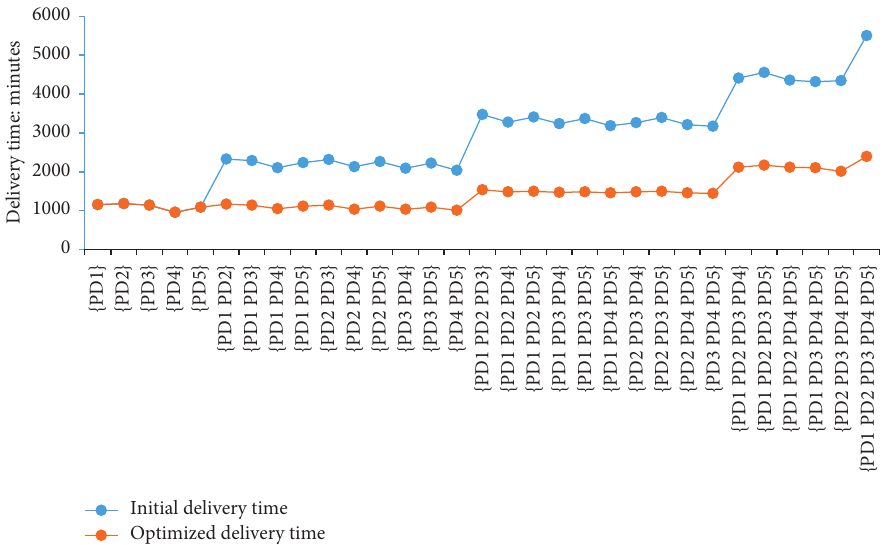
Figure 6: Comparison between initial and optimized network delivery time solutions.